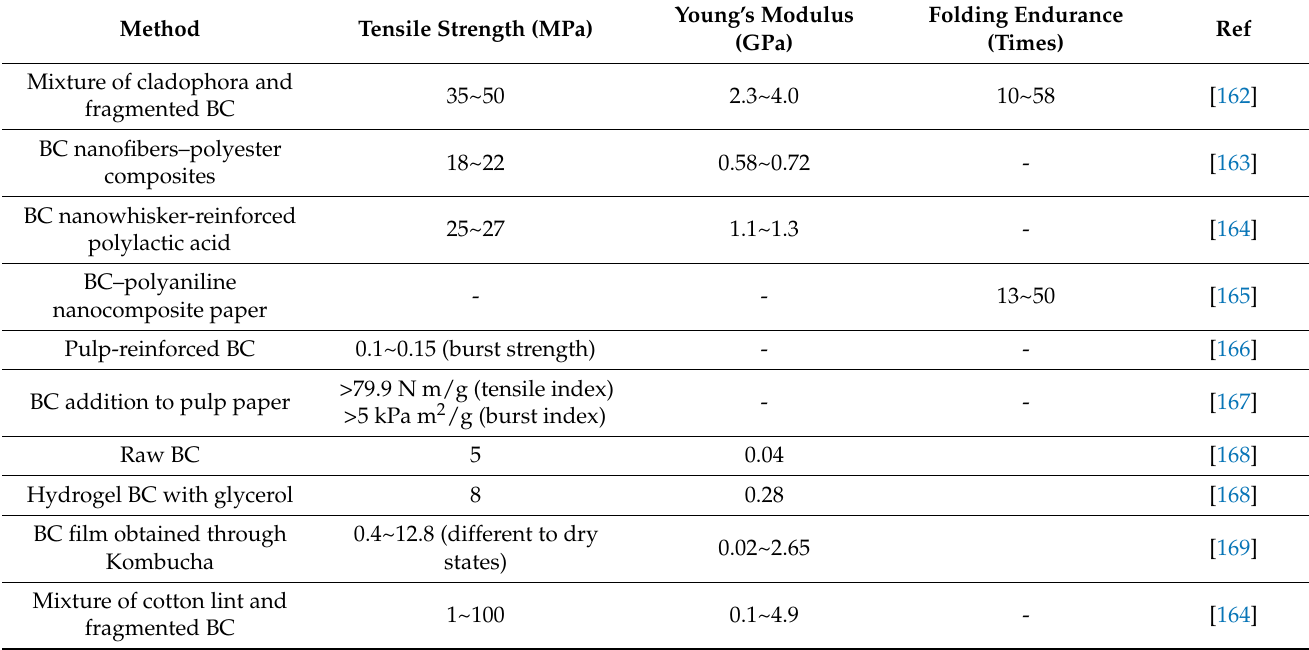
Table 1. The mechanical properties of bacterial cellulose (BC) and BC composited